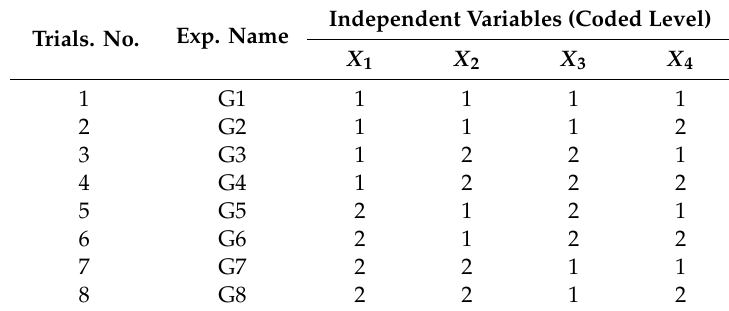
Table 2. 2 4 Taguchi design: coded values for the independent variables. Trials.